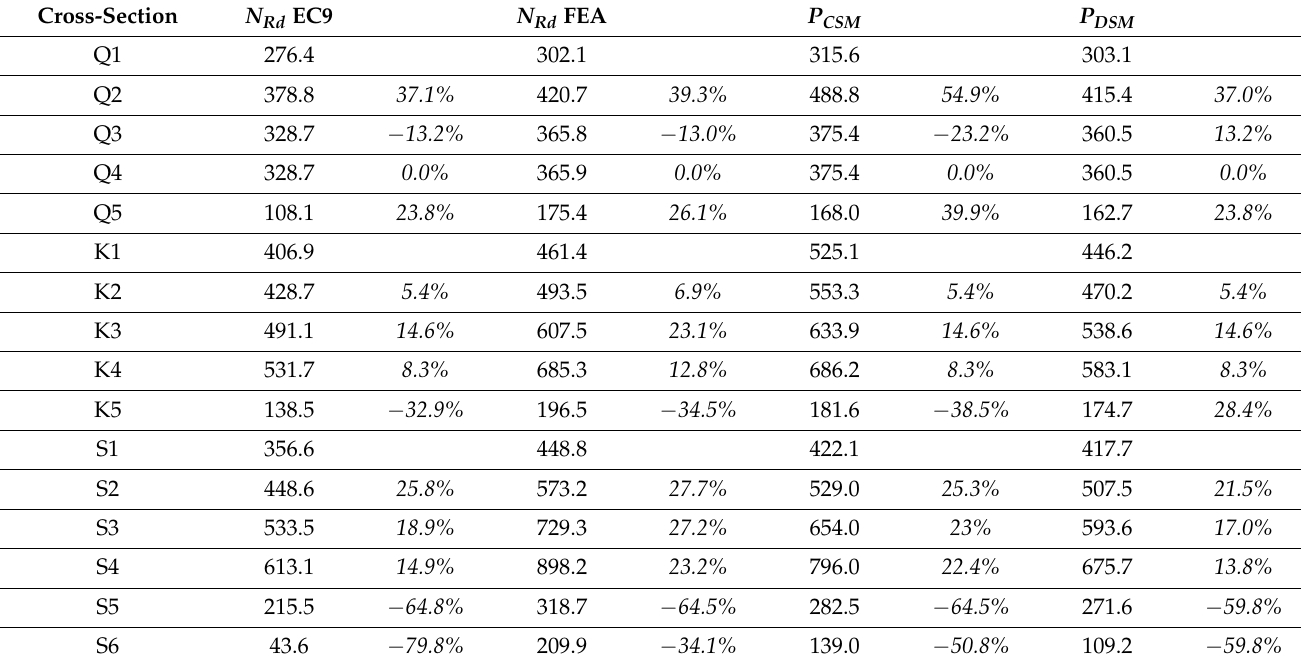
Table 3. Ultimate strength as calculated by EC9, CSM, and DSM formulae and as obtained from FEA. Increase/decrease percentages from one cross-section to another are also presented. Strength values are given in